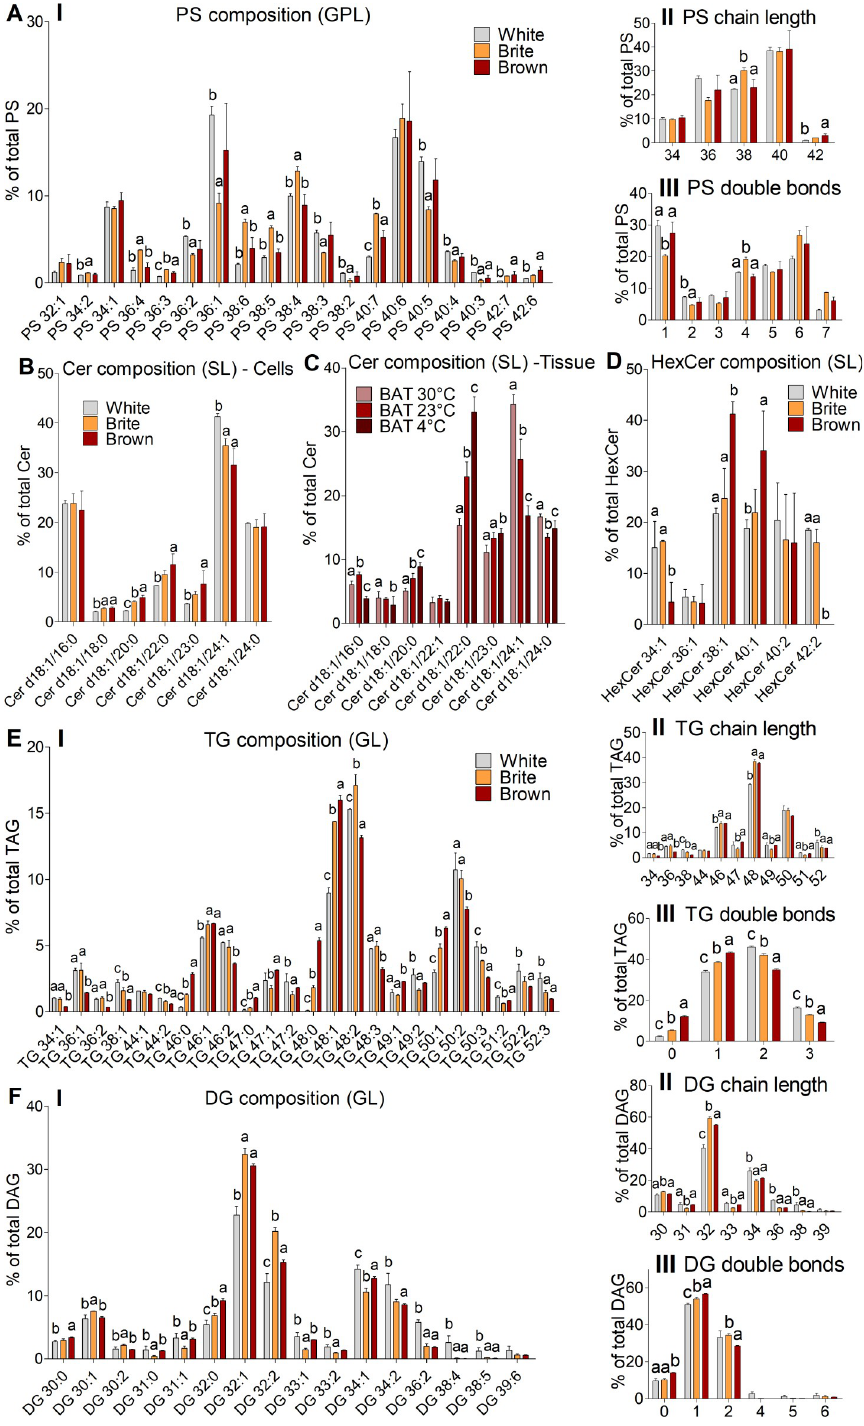
Fig 4. PS (GPL), Cer and HexCer (SL), TG and DG (GL) species composition of white, brite, and brown adipocytes; Cer (SL) profile of BAT at different browning degrees. (A) PS, (B) Cer in adipocytes; (C) Cer in BAT samples from mice housed for 7 days at 4˚C, 23˚C, or 30˚C; (D) HexCer, (E) TG, (F) DG in adipocytes. Panels show (I) species composition, (II) chain length as the number of carbons in the sum of FA moieties, (III) saturation as the number of double bonds in the sum of FA moieties. For adipocytes (A–B, D–F) means ± SD of 3 independent experiments are shown, each performed in triplicates with AT pooled from 3 mice; for BAT (C), the means ± SD